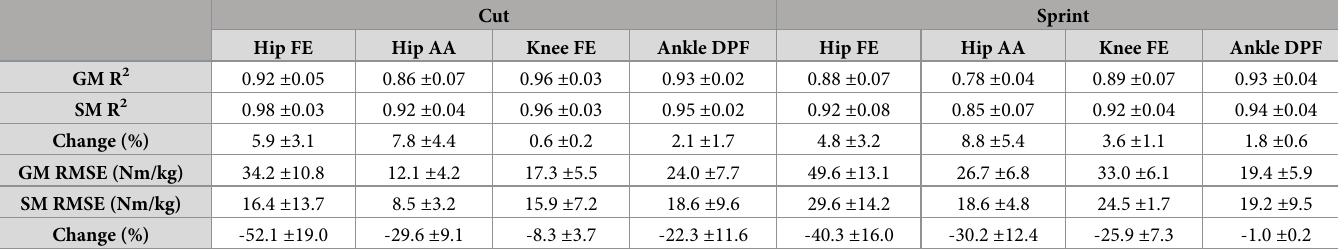
Table 3. Matching of joint moments predicted by CEINMS to those from inverse dynamics for generic and subject-specific models. Cut Sprint Hip FE Hip AA Knee FE Ankle DPF Ankle